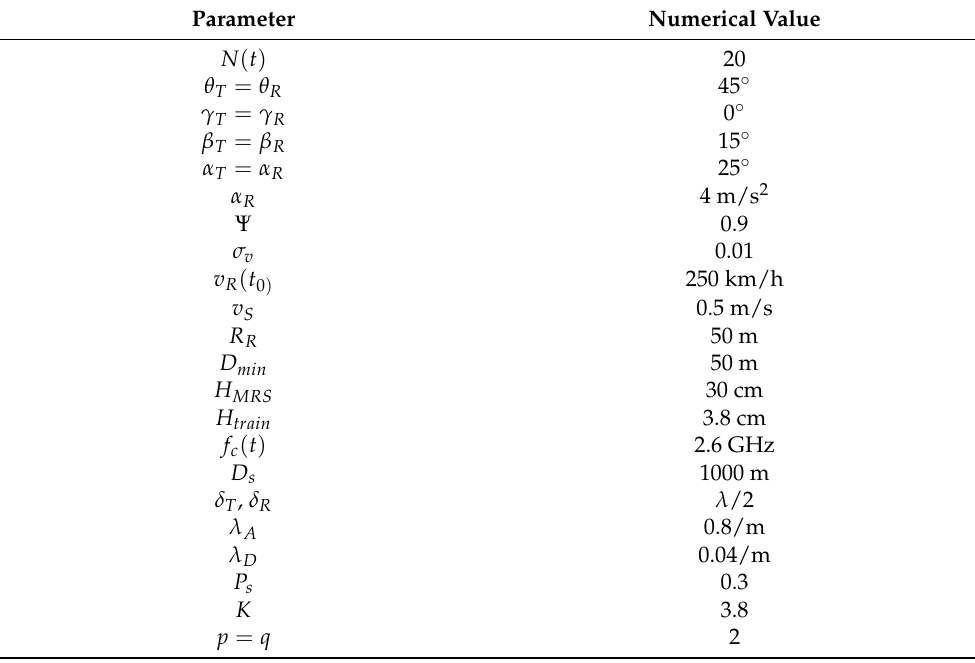
Table 2. Numerical values used for the simulation model.